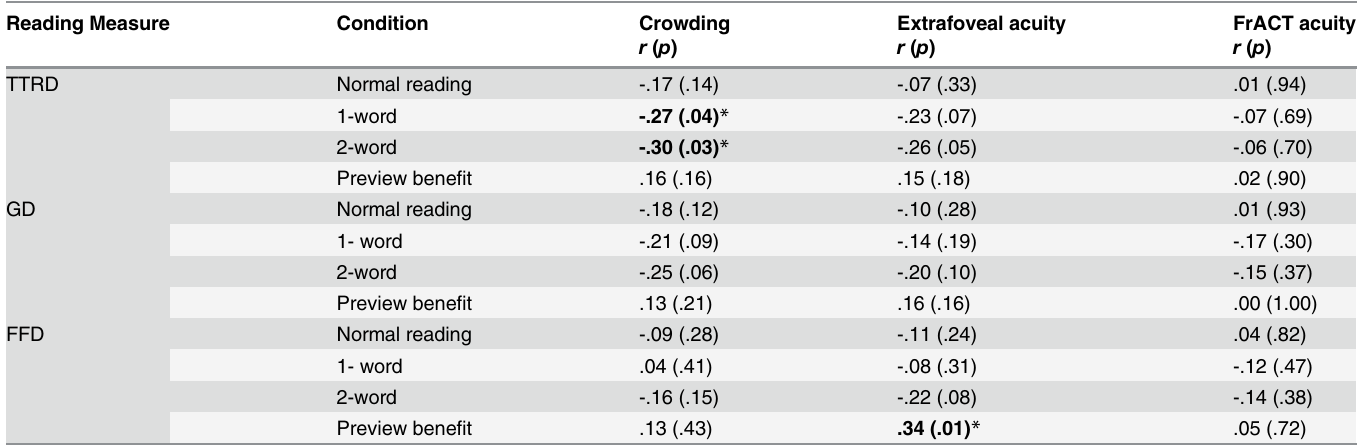
Table 4. Correlations between vision and reading measures. Reading